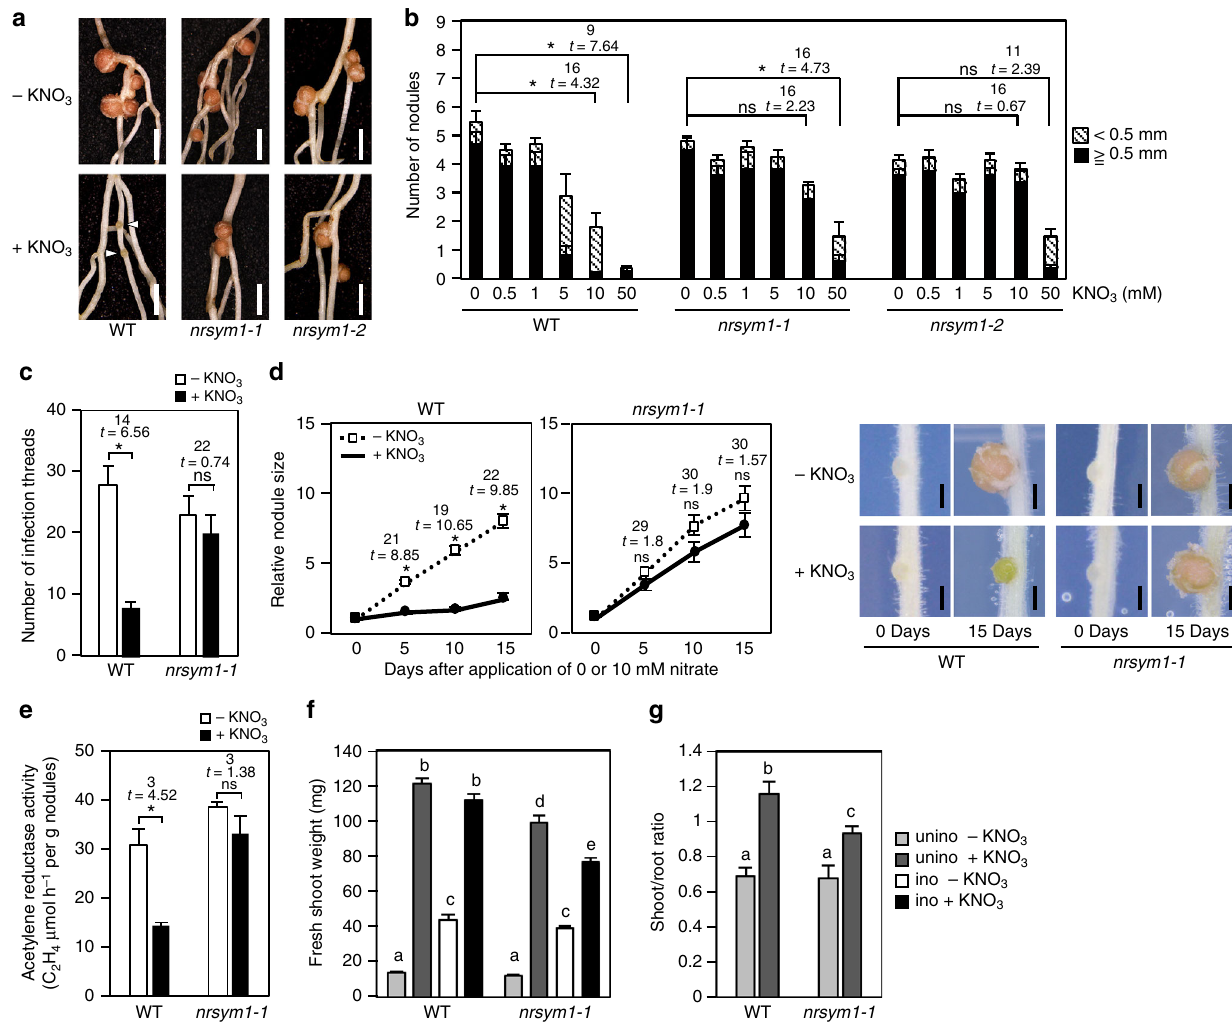
Fig. 1 The effect of the nrsym1 mutation on nodulation and plant growth. a Nodule phenotypes of WT, the nrsym1-1 mutant, and the nrsym1-2 mutant treated with 0 or 10 mM KNO 3 at 21 days after inoculation (dai). Arrowheads indicate small and premature nodules. Scale bars: 2 mm. b The number of nodules in WT, the nrsym1-1 mutants, and the nrsym1-2 mutants in the presence of different concentrations of KNO 3 (0 – 50 mM) at 21 dai ( n = 9 plants). c The number of infection threads in WT and the nrsym1-1 mutants with 0 or 10 mM KNO 3 at 7 dai with rhizobia that constitutively express LacZ ( n = 12 plants). d Relative nodule size (daily nodule size/nodule size on day 0) of WT and the nrsym1-1 mutants ( n = 13 – 19 nodules). Individual nodule size was measured at 0, 5, 10, and 15 days after the transfer to agar plates with 0 or 10 mM KNO 3 . * P < 0.05 (Student ’ s t -test compared 0 mM KNO 3 -treated nodules with 10 mM KNO 3 - treated nodules on the same day). ns, not signi fi cant. Scale bars: 0.5 mm. e Acetylene reduction activity (ARA; μ mol h − 1 per g nodules) of nodules formed on WT and the nrsym1-1 mutants ( n = 4 plants). Twenty-one dai plants without KNO 3 were supplied with 0 or 10 mM KNO 3 , and after 3 days the ARA of nodules from each plant was measured. f Fresh shoot weight and ( g ) shoot to root fresh weight ratio of WT and the nrsym1-1 mutants grown in 0 or 10 mM KNO 3 on 21 dai (ino) or without rhizobia (unino; n = 10 – 12 plants). Error bars indicate SEM. * P < 0.05 by Student ’ s t -test. ns, not signi fi cant. Degrees of freedom are shown above the t -values ( b – e ). Columns with the same lower-case letter indicate no signi fi cant difference (Tukey ’ s test, P < 0.05; f , g